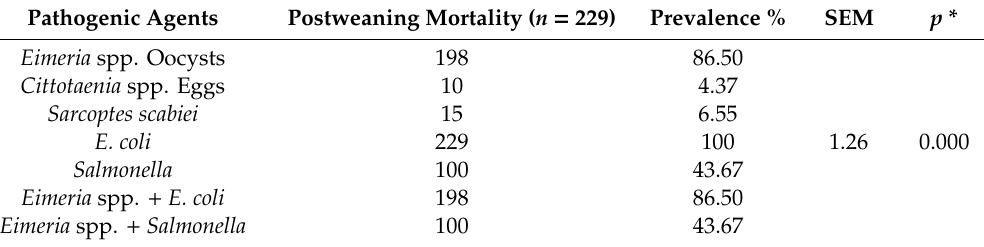
Table 4. Prevalence of pathogenic causes in postweaning periods in